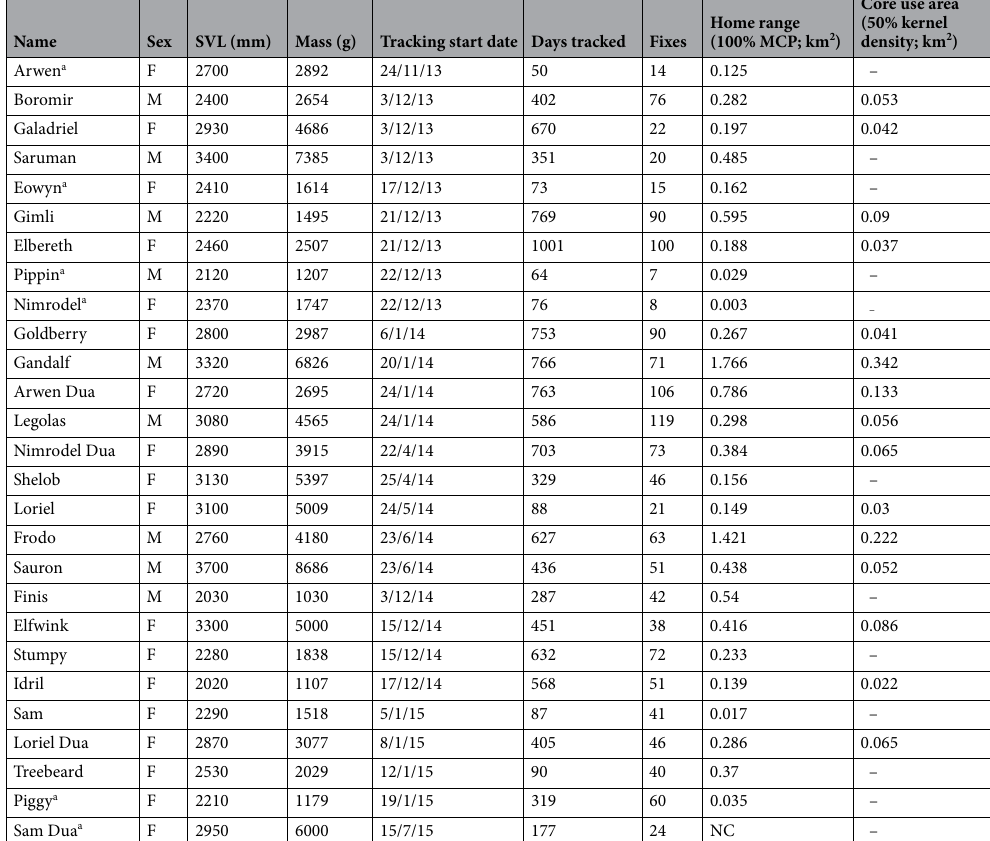
Table 1. Attributes (sexes, sizes) of radio-tracked scrub pythons ( Simalia amethistina ) in north Queensland, with data on the duration of radiotelemetric monitoring, number of times a snake was located (“fixes”) and home range sizes based on 100% minimum convex polygons (MCP) and core use areas based on 50% kernel density estimates. SVL snout-vent length. a Denotes specimens for which MCP home range estimates should be viewed with caution due to the low number of fixes or altered movement behaviour (see “Methods”). These specimens were not included in our home range